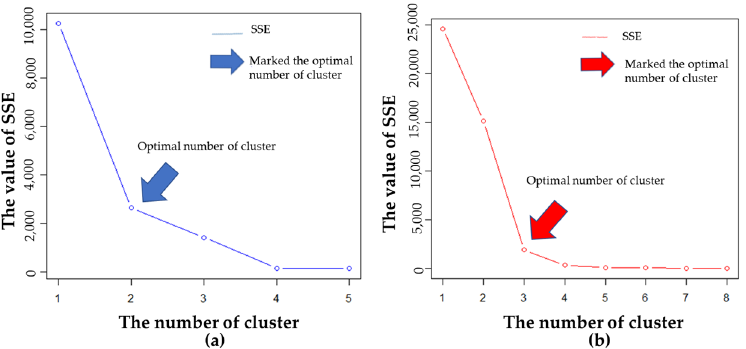
Figure 11. ( a ) The optimal number for the medium EDRI (the blue arrow indicates the optimal numbers of clusters) ( b ) The optimal number for the high EDRI (the red arrow indicates the optimal numbers of clusters).